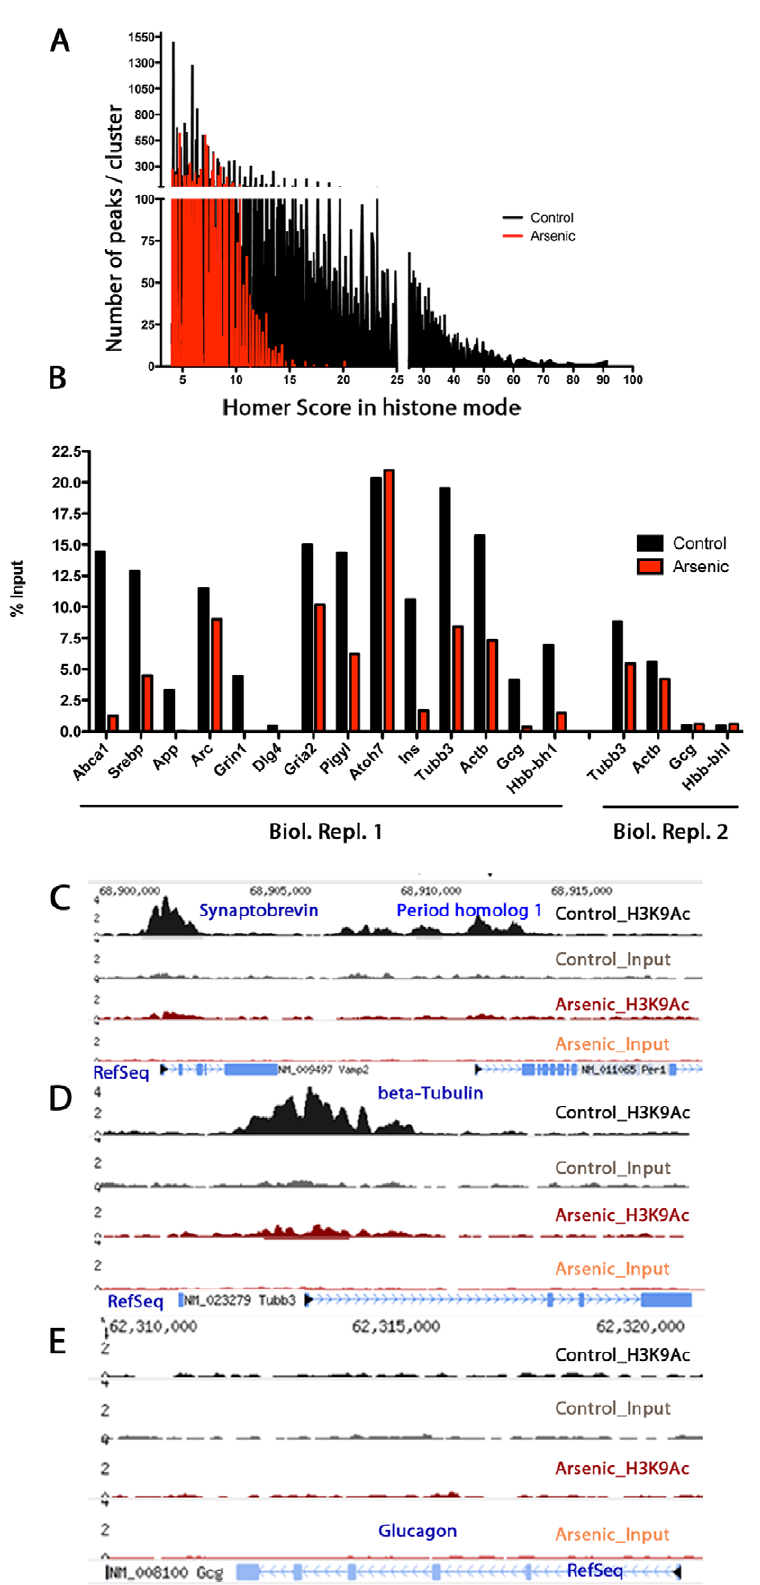
Figure 2. Global hypoacetylation at H3K9 in response to arsenic exposure during embryonic life. Each of the clusters on the histogram in Panel A represent all significant peaks of enrichment with the same HOMER score from arsenic (in red 6.71 median, 6.86 average, 4.03 min, 20.13 max, 8577 total peaks) and control (in black: 9.07 median, 11.70 average, 4.02 min, 91.62 max, 37946 total peaks) treated samples. B . ChIP-QPCR